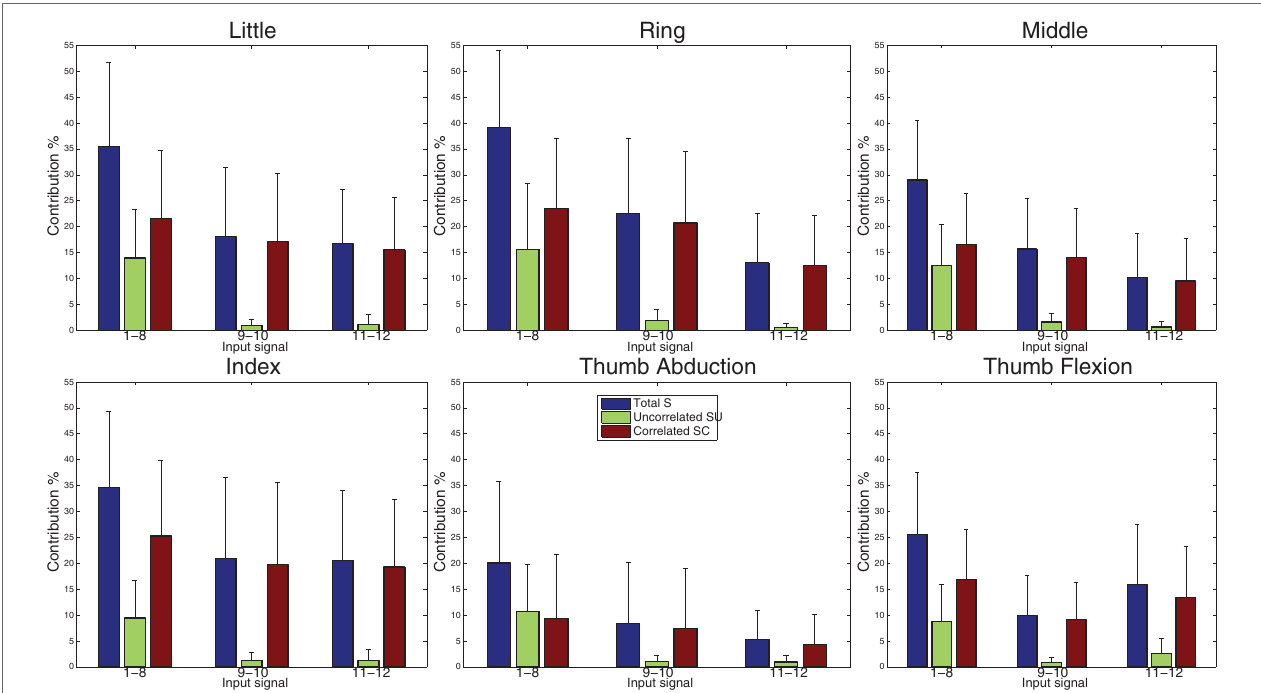
FIGURE 10 | Variance contribution for the six force signals using regression-based sensitivity analysis for correlated inputs (using the MoE model obtained with FILT FE) for grouped sEMG input signals, averaged over all 40 subjects. The large SU values (green) indicate that the group of inputs 1–8 is influential.